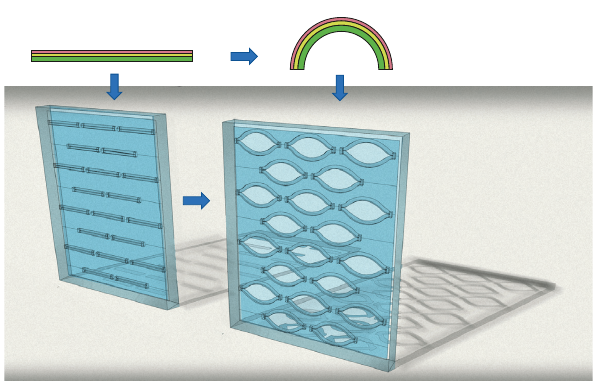
Figure 8: Schematic diagram of composite SMPs in shading controls.